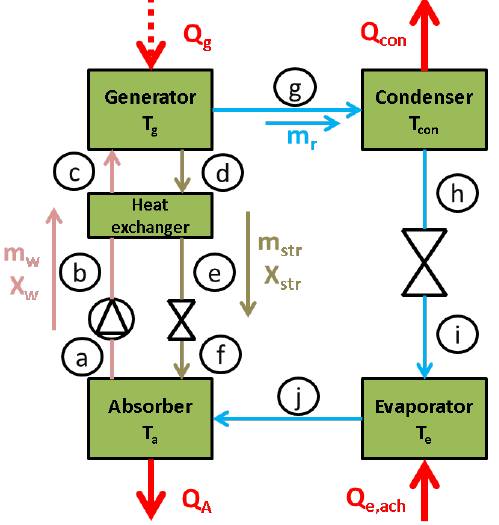
Figure A1. The examined absorption chiller.